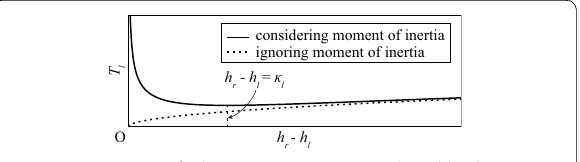
Fig. 5 Comparison of T l between point‑mass and rigid‑body pendulum